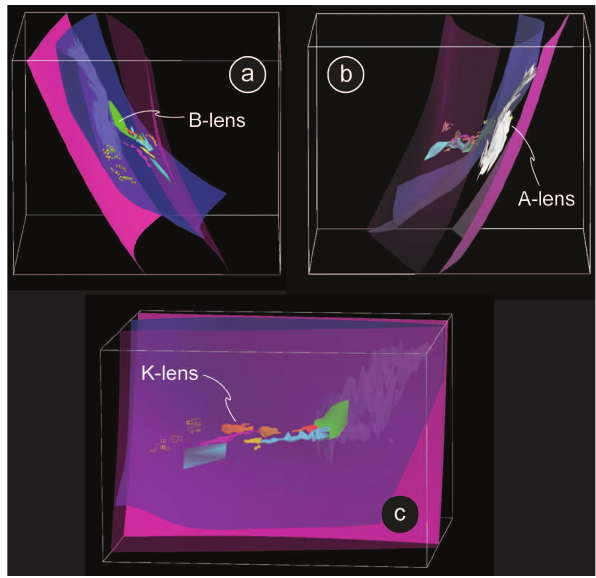
Fig. 3. gOcad screenshots illustrating the geometry of the Kristineberg deposit VMS lenses. (a) Cross-sectional view towards east. (b) Cross-sectional view towards west. (c) Longitudinal view towards north. Selected high-strain zones are shown for reference in different shades of magenta (see “Supplement” for details). Height of the bounding boxes are